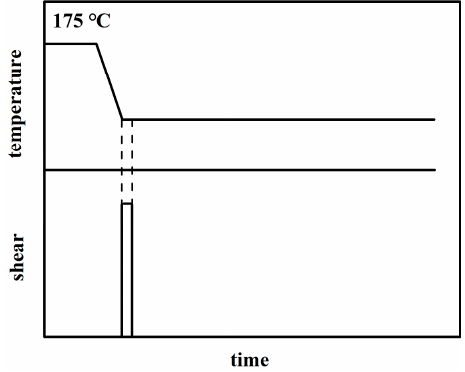
Figure 1. Scheme of the experimental protocol.